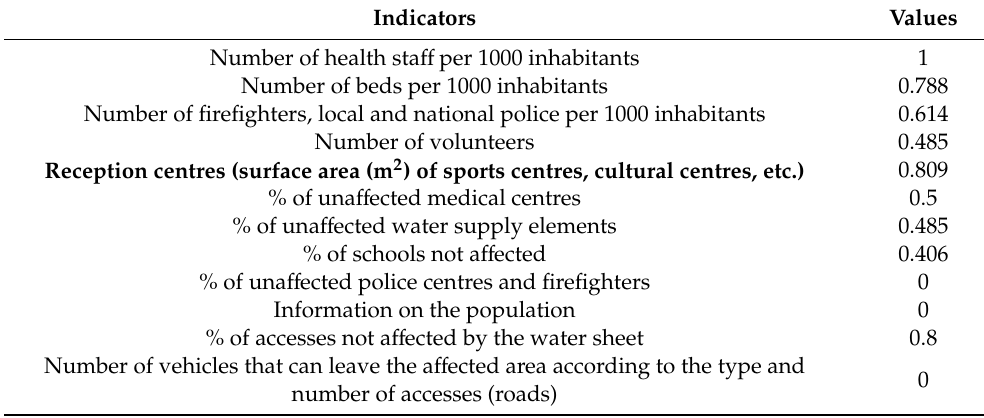
Table 6. Values of indicators of health, security and community equipment in